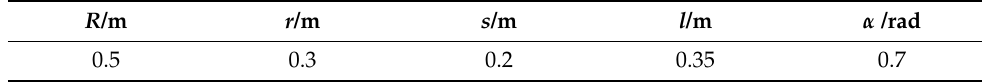
Table 2. The geometric parameters of 3PUU-3RPS mobile